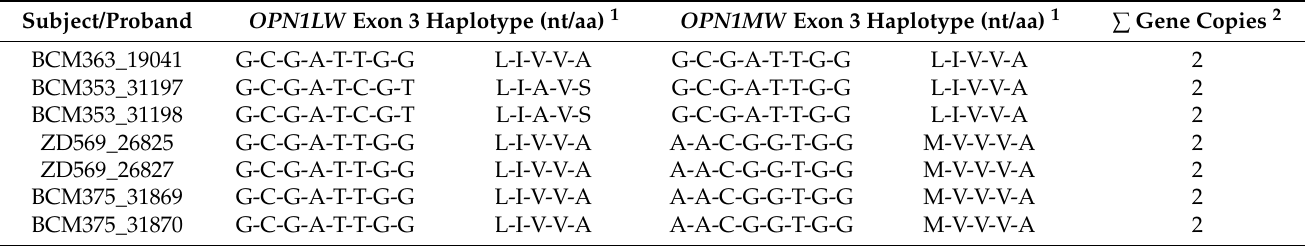
Table 1. OPN1LW and OPN1MW exon 3 genotypes in the study